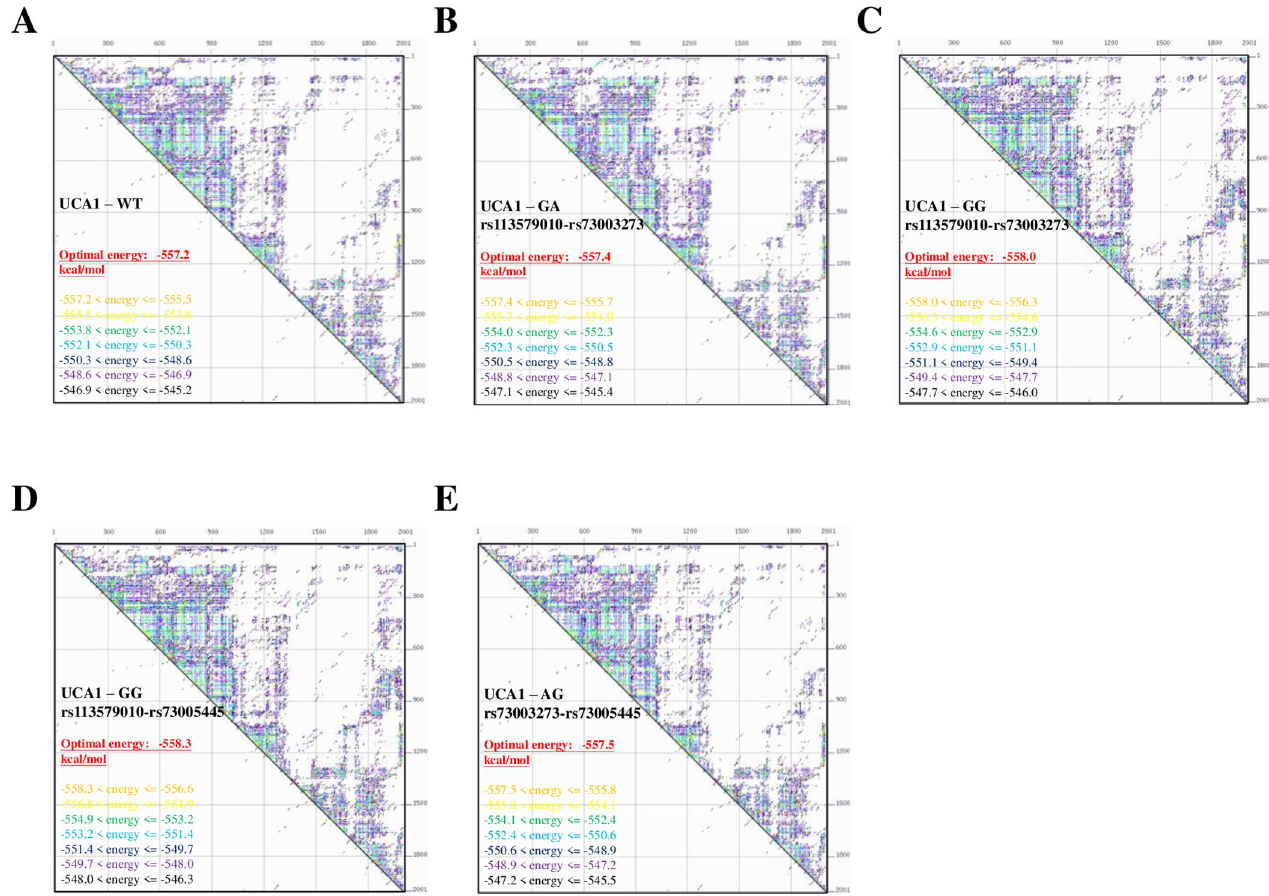
Fig 3. Thermo-stability changes in UCA1 variants with different haplotypes. Thermo-stability of ( A ) wild-type UCA1, ( B ) UCA1 variant with the GA haplotype of rs113579010-rs73003273, ( C ) UCA1 variant with the GG haplotype of rs113579010-rs73003273, ( D ) UCA1 variant with the GG haplotype of rs113579010-rs73005445, and ( E ) UCA1 variant with the AG haplotype of rs73003273-rs73005445. Thermo-stability of those UCA1 variants were predicted by UNAfold web server (www.unafold.org/mfold/applications/rna-folding-form-v2.php).